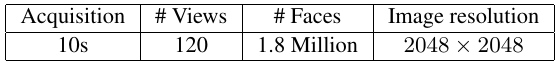
Table 1. Statistics on the input data per chunk